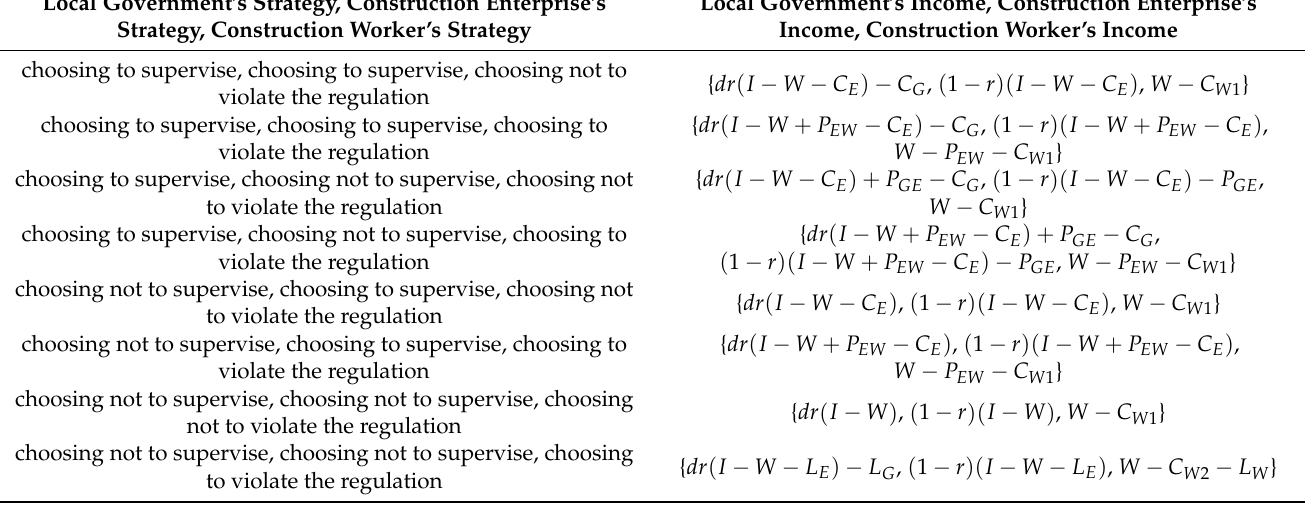
Table 2. Income of game players under different game